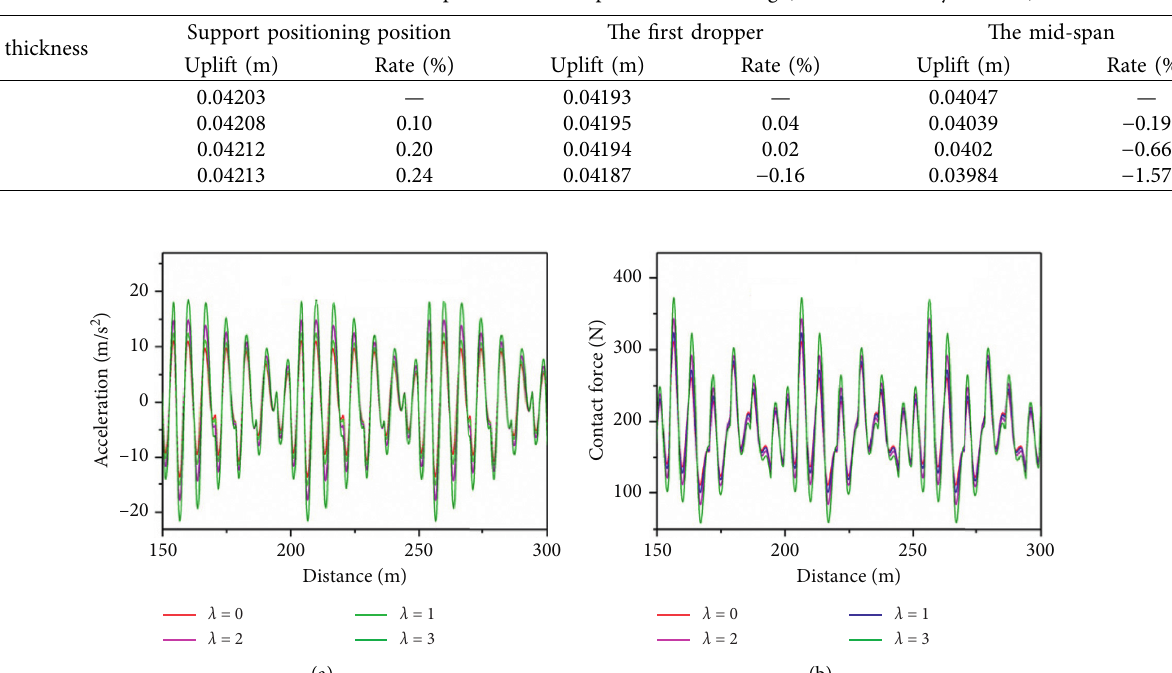
Figure 6: Characteristic curve of specific point (increased density method). (a) Support positioning position. (b) The first dropper. (c) The mid-span. Table 4: Statistical value of vertical uplift at different positions after icing (increased density